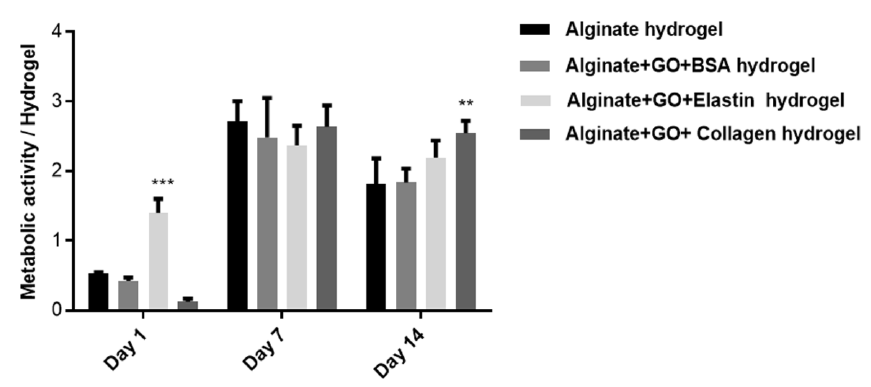
Figure 10. Metabolic activity of hybrid alginate-GO embedded C 2 C 12 -EPO myoblasts over two weeks. Note: **: p < 0.01; ***: p < 0.001 compared with cells encapsulated in alginate without GO.